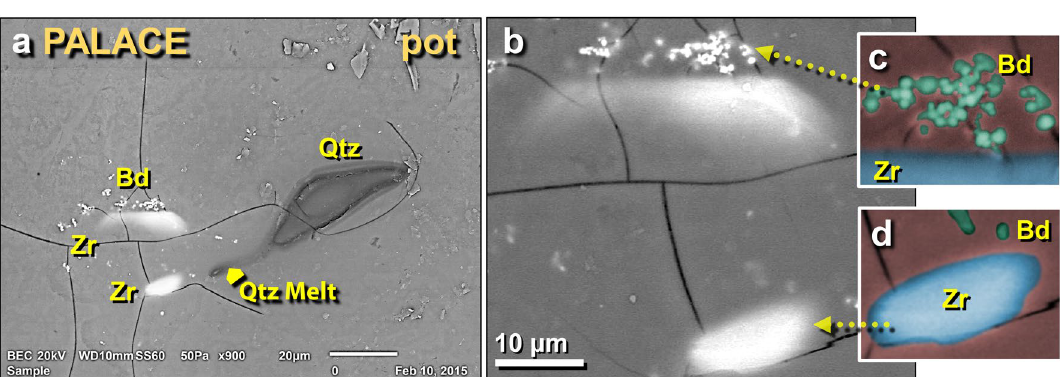
Figure 31. SEM images of other melted zircon grains in palace potsherd. ( a ) Two melted zircon grains adjacent to a previously discussed melted quartz grain; ( b ) close-up of same zircon grains; ( c ) manually constructed EDS- based phase map showing baddeleyite grains in green. The blue area represents melted zircon, while the red background represents the Ca–Al–Si matrix of the melted pottery. ( d ) Manually constructed EDS-based phase map of zircon grain showing small baddeleyite grains in green at the